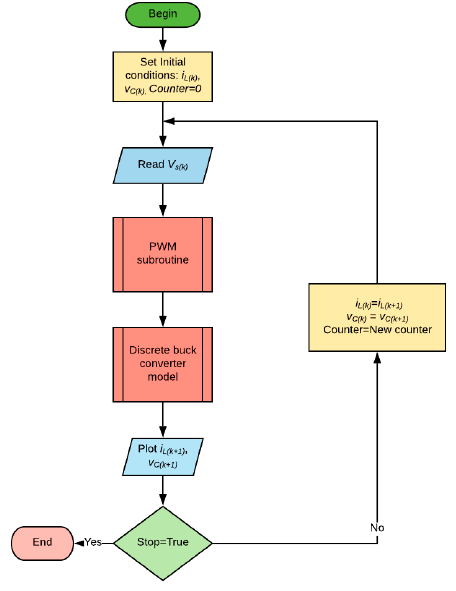
Figure 6. Flow diagram of the off-line simulation of the buck converter.